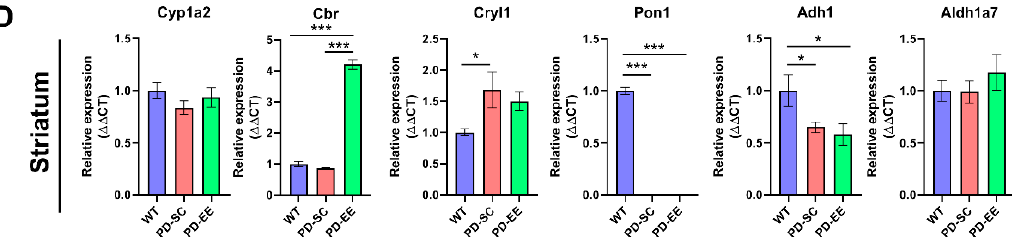
Figure 6. EE altered levels of detoxifying enzymes in the brain tissues of PD mice. ( A , B ) In the olfactory bulb and brain stem, we observed significant overexpression of all examined enzymes in the PD-SC, and EE significantly o ff set these up-regulation, except Adh1 in the olfactory bulb ( n = 3–4). ( C , D ) These tendencies were not apparent in the frontal cortex and striatum. In the frontal cortex, the levels of only Cyp1a2 and Cbr2 were higher in the PD-SC compared both WT and PD-EE. Moreover, in the striatum, several enzymes such as Pon1 and Adh1 , were overexpressed in the WT compared to the other groups ( n = 3–4). * p < 0.05, ** p < 0.01, *** p < 0.001; one-way ANOVA followed by post-hoc comparison. Cyp1a2 , cytochrome P450 family 1 subfamily A member 2; Cbr2 , carbonyl reductase2; Cryl1 , crystallin lambda 1; Pon1 , paraoxonase 1; Adh1 , alcohol dehydrogenase 1; Aldh1a7 , aldehyde dehydrogenase 1A7.